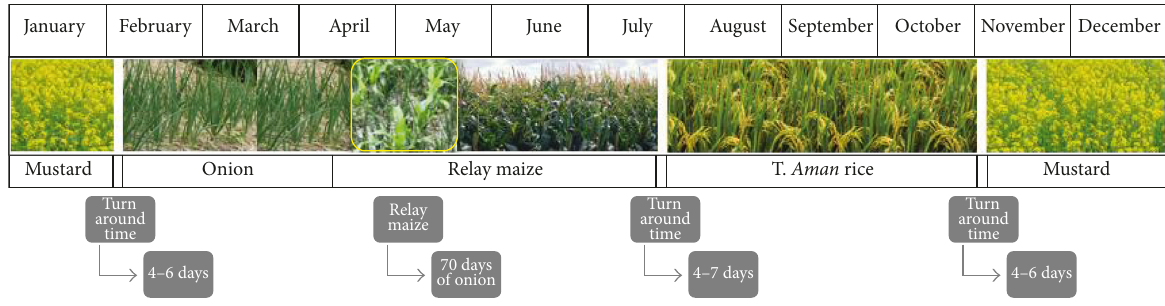
Figure 2: Calendar year of four crops